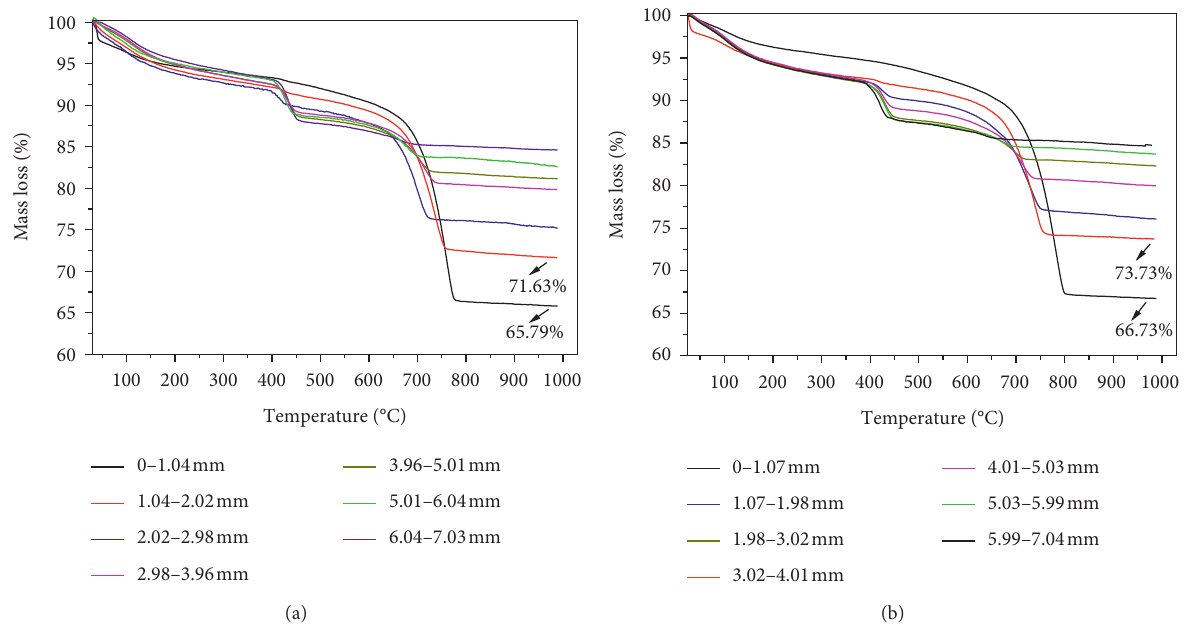
Figure 8: Mass loss curves at different depths of samples in the mineralization group (a) and the carbonization group (b).